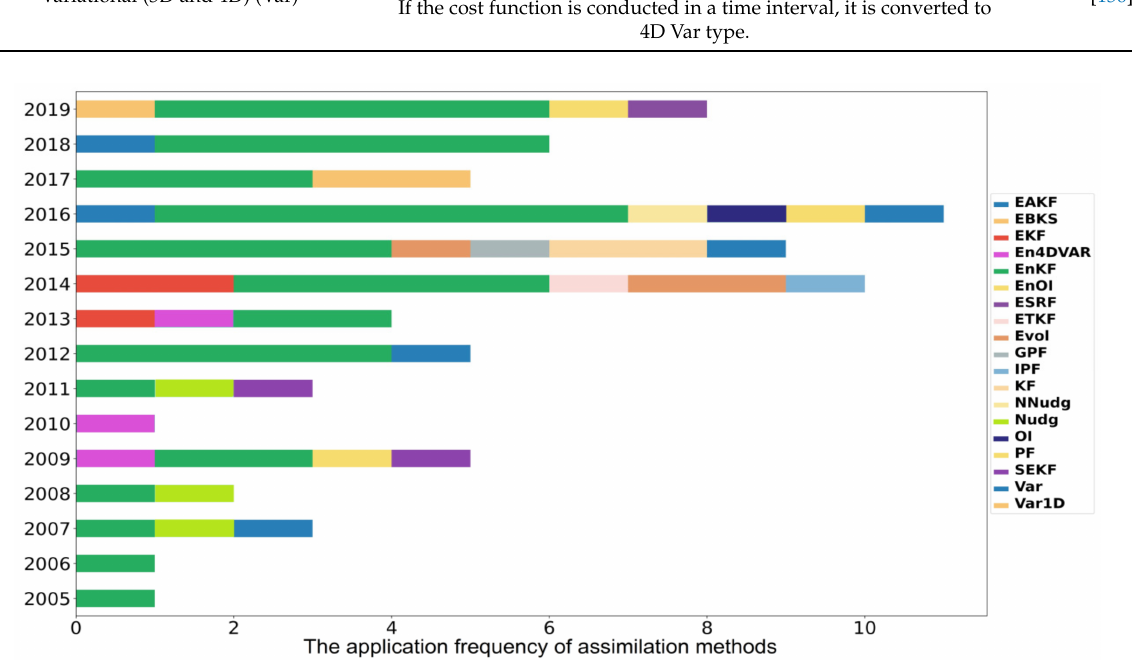
Figure 7. The application frequency of each assimilation method for the improvement of SM in LSMs in each year from 2005 to